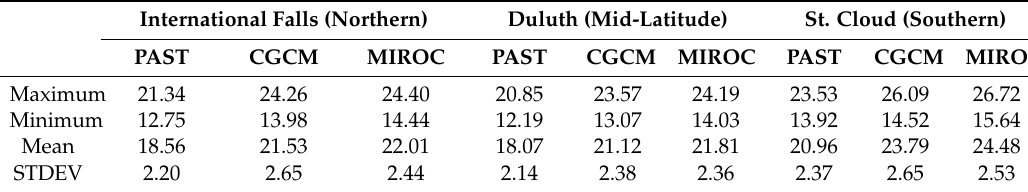
Table 5. Statistics of AvgATDO3 VB ( ◦ C) under the past climate conditions (1962–2008) and the future climate scenarios CGCM 3.1 and MIROC 3.2 for the 24 medium-deep virtual lakes. Simulations and analysis were made with weather data input from weather stations in International Falls, Duluth, and St.